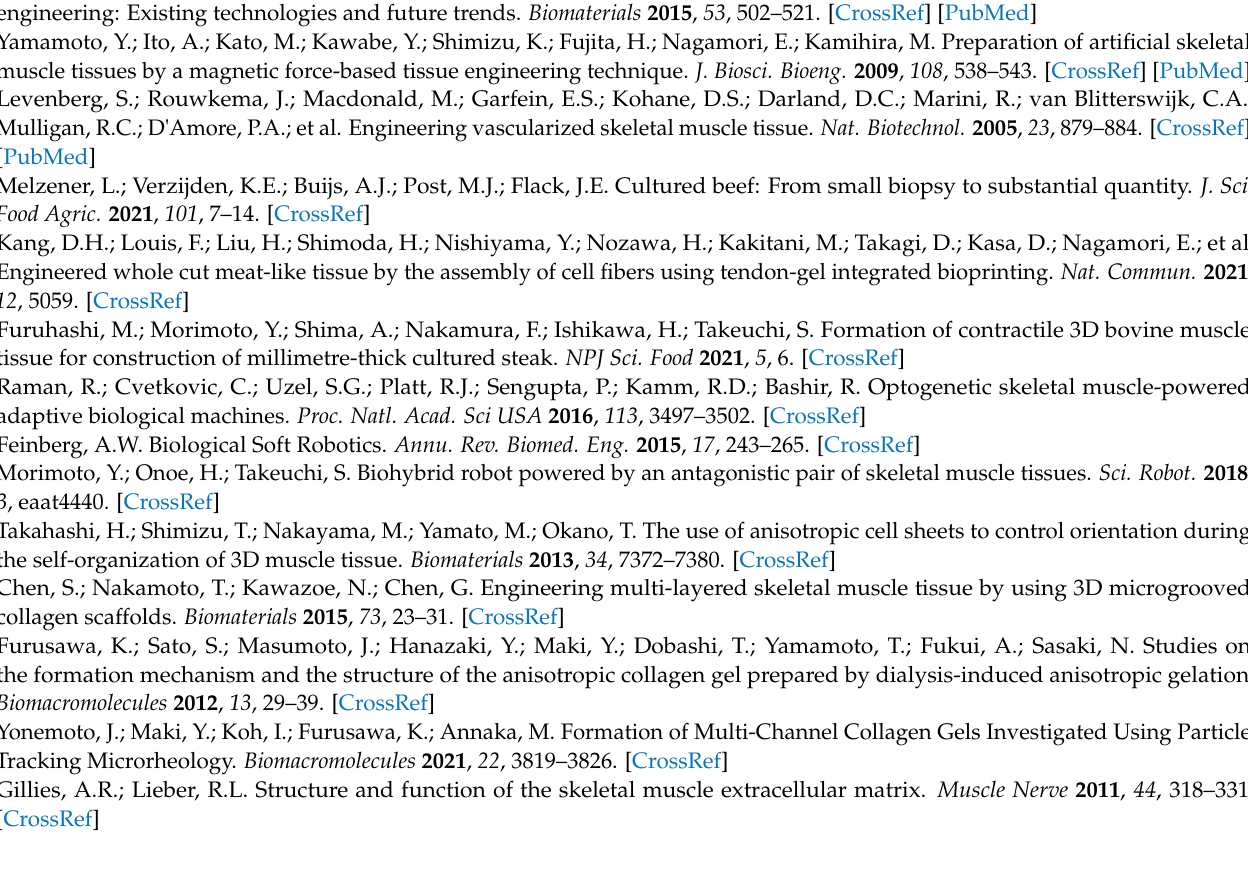
an anisotropy of elastic modulus of a CT, Figure S2: Curve fittings for the relaxation moduli of EMT, Figure S3: Relaxation moduli of MCCG, Figure S4: Relaxation moduli of CT, Figure S5: Curve fittings for the relaxation moduli of MCCG, Figure S6: Curve fittings for the relaxation moduli of CT, Figure S7: Comparing the relaxation parameters of EMT, MCCG and CT, Figure S8: Schematic illustrations of molds for preparing MCCGs, Figure S9: A photograph of the hand-maid electrode for electrostimulation to EMT, Movie S1: Autonomous contraction of myotubes on a 24-well cell culture plate, Movie S2: Autonomous contraction of myotubes in micro-channels of EMT, and Movie S3: Electrostimulation of